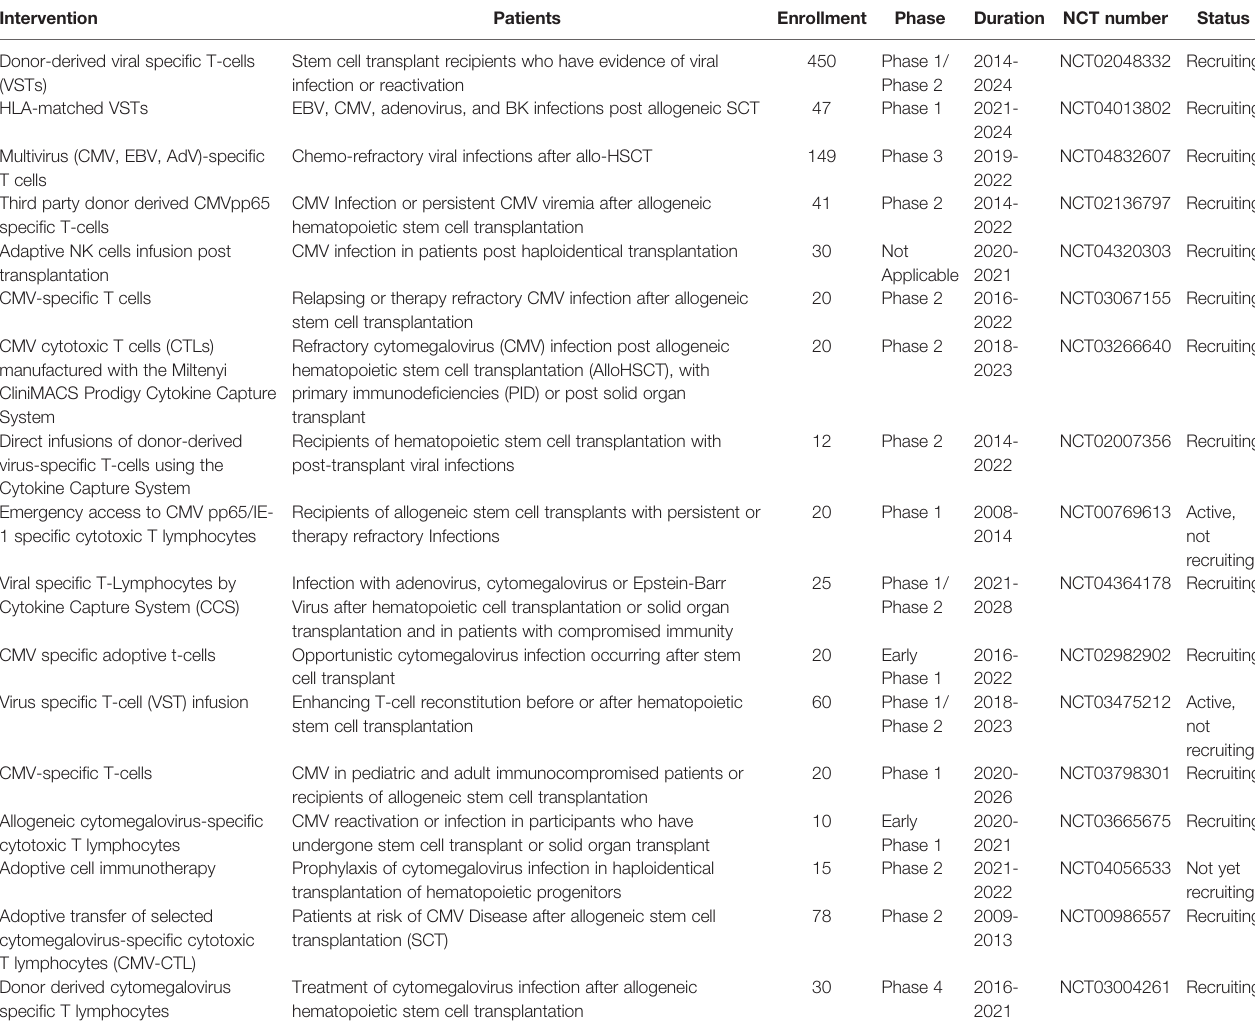
TABLE 2 | Ongoing clinical trials using cytomegalovirus-speci fi c cellular immunotherapy for allo-SCT patients including haploidentical SCT (accessed on 5 Oct 2021, ClinicalTrials.gov).